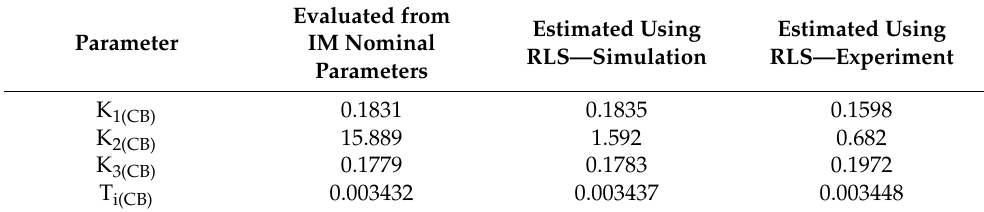
Figure 4. Simulation result: identification of observers parameters using self-tuning algorithm—motor excitation, acceleration from 0 to 100 rpm at 0.5 s; ( a ) reference (blue) and measured (pink) speed; ( b ) flux (blue) and torque (pink) producing stator current components; ( c ) observer parameters (K 1(CB) , K 2(CB) , K 3(CB) , T i(CB) ).